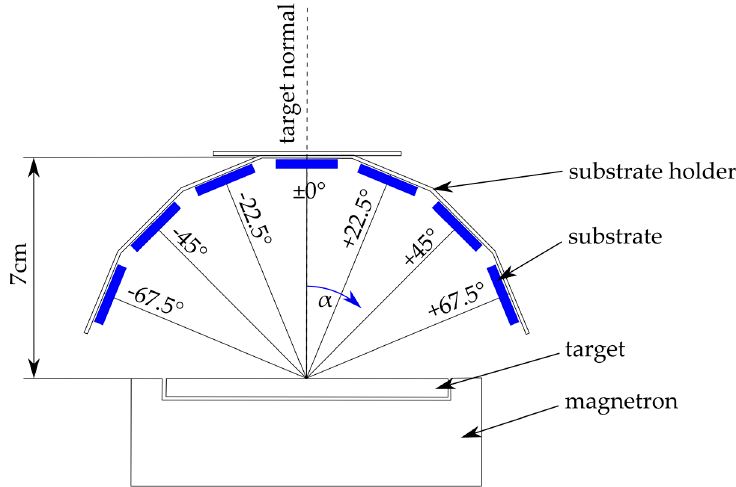
Figure 1. XRD pattern of the powder-metallurgically manufactured Mo 2 BC compound target. Small phase fractions of Mo 2 C and MoC were detected.